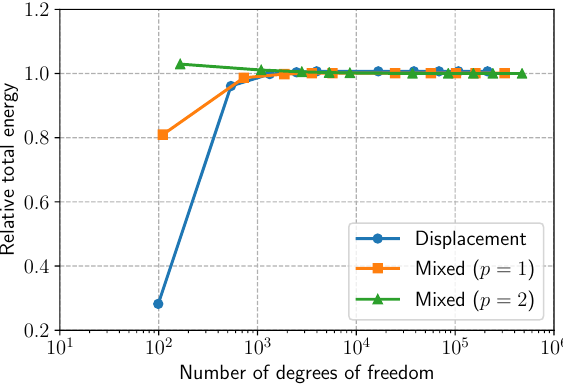
Figure 3. Total energy convergence for the clamped thick plate